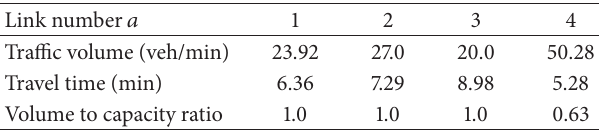
Figure 1: A signal-controlled road network. Table 1: Input data to the example network.